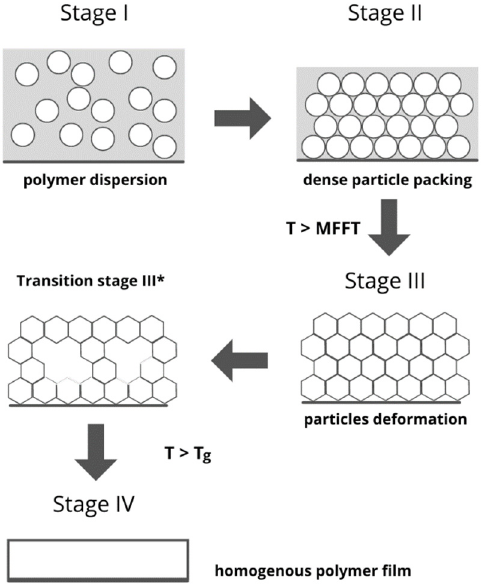
Figure 6. Schematic representation of polymer film formation from aqueous dispersion, stages from I to IV (based on literature [95]).